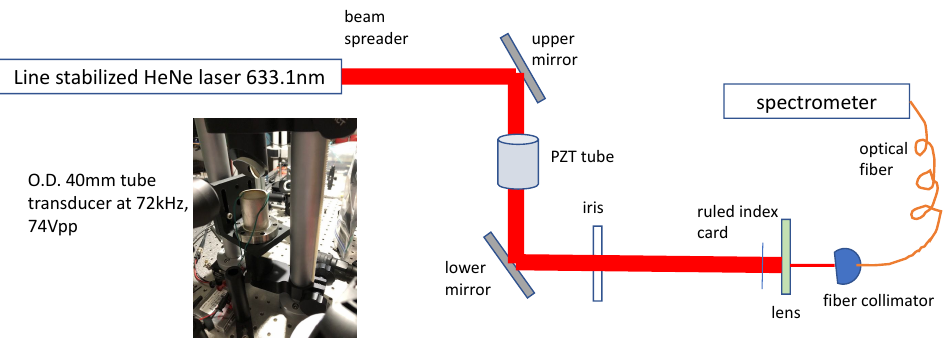
Figure 1. The laser beam passes through a beam spreader, then via a mirror through the PZT tube, another mirror, an iris, and finally either to a ruled index card or focused into the fiber collimator, where the light is analyzed by the spectrometer. The inset photo shows the PZT tube mounted between the two beam steering mirrors. The PZT tube was filled with pharmaceutical grade